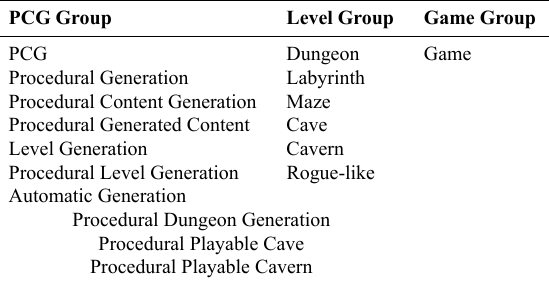
Table 1. Search terms. The terms were divided into three groups we defined to compose the search string: PCG, level, and